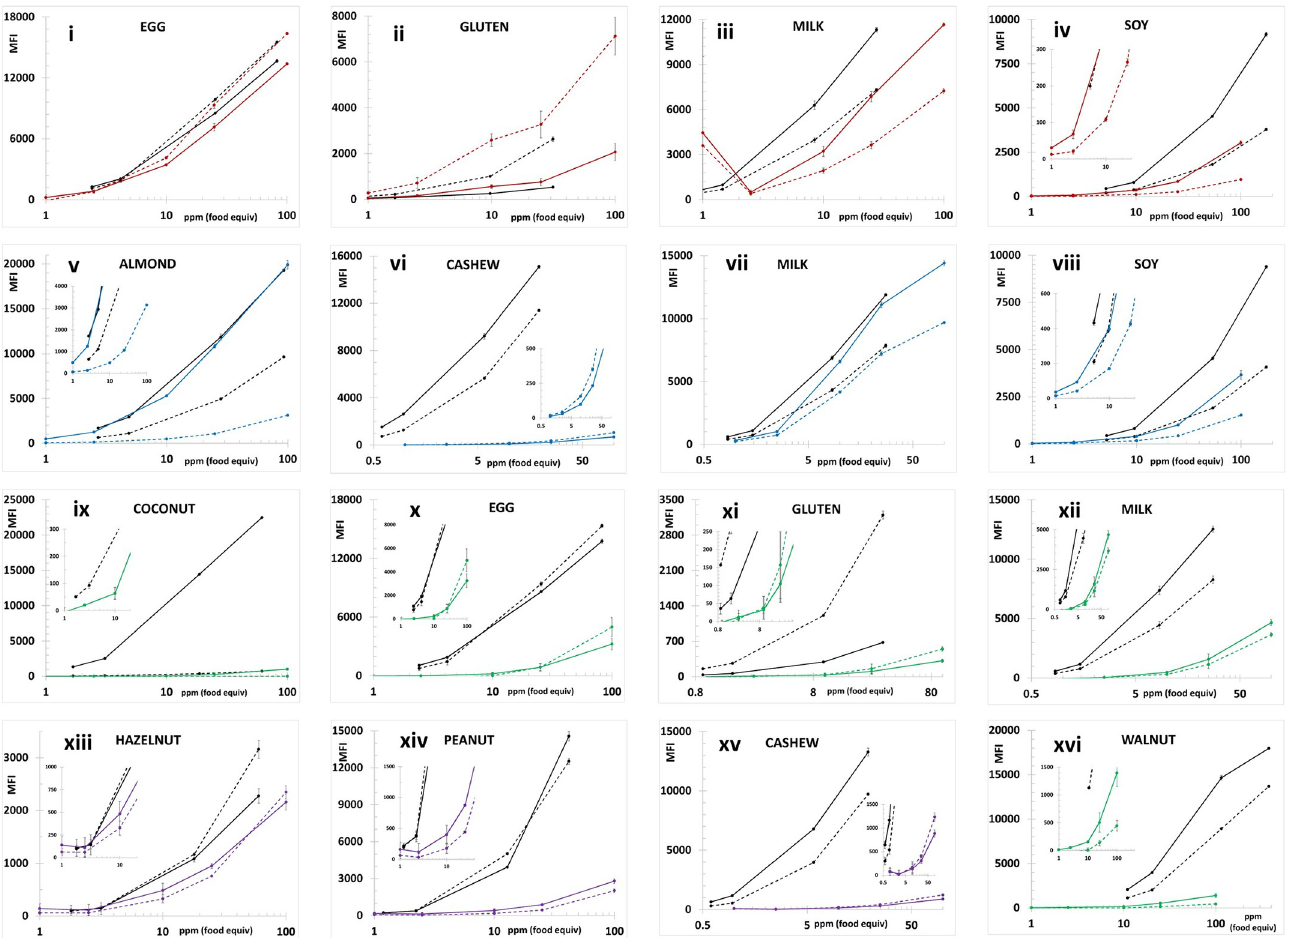
Fig 7. Average MFI of bead sets generating MFI with incurred food samples by Lab 11. Same as Fig 4 except the average of only the triplicate analyses generated by Lab 11.